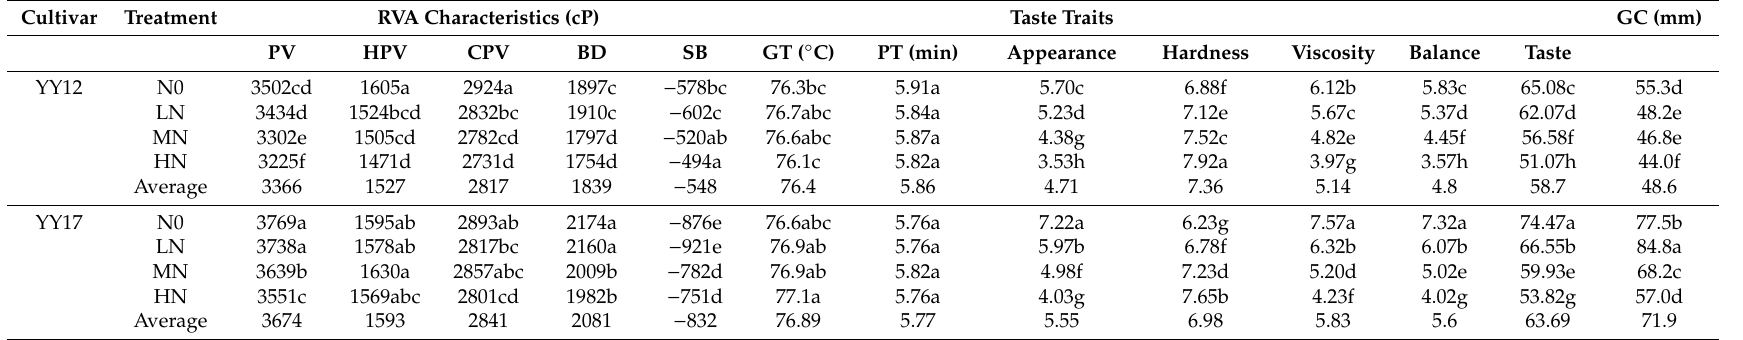
Table 1. Rapid Visco Analyser (RVA) characteristics and taste traits under di ff erent nitrogen